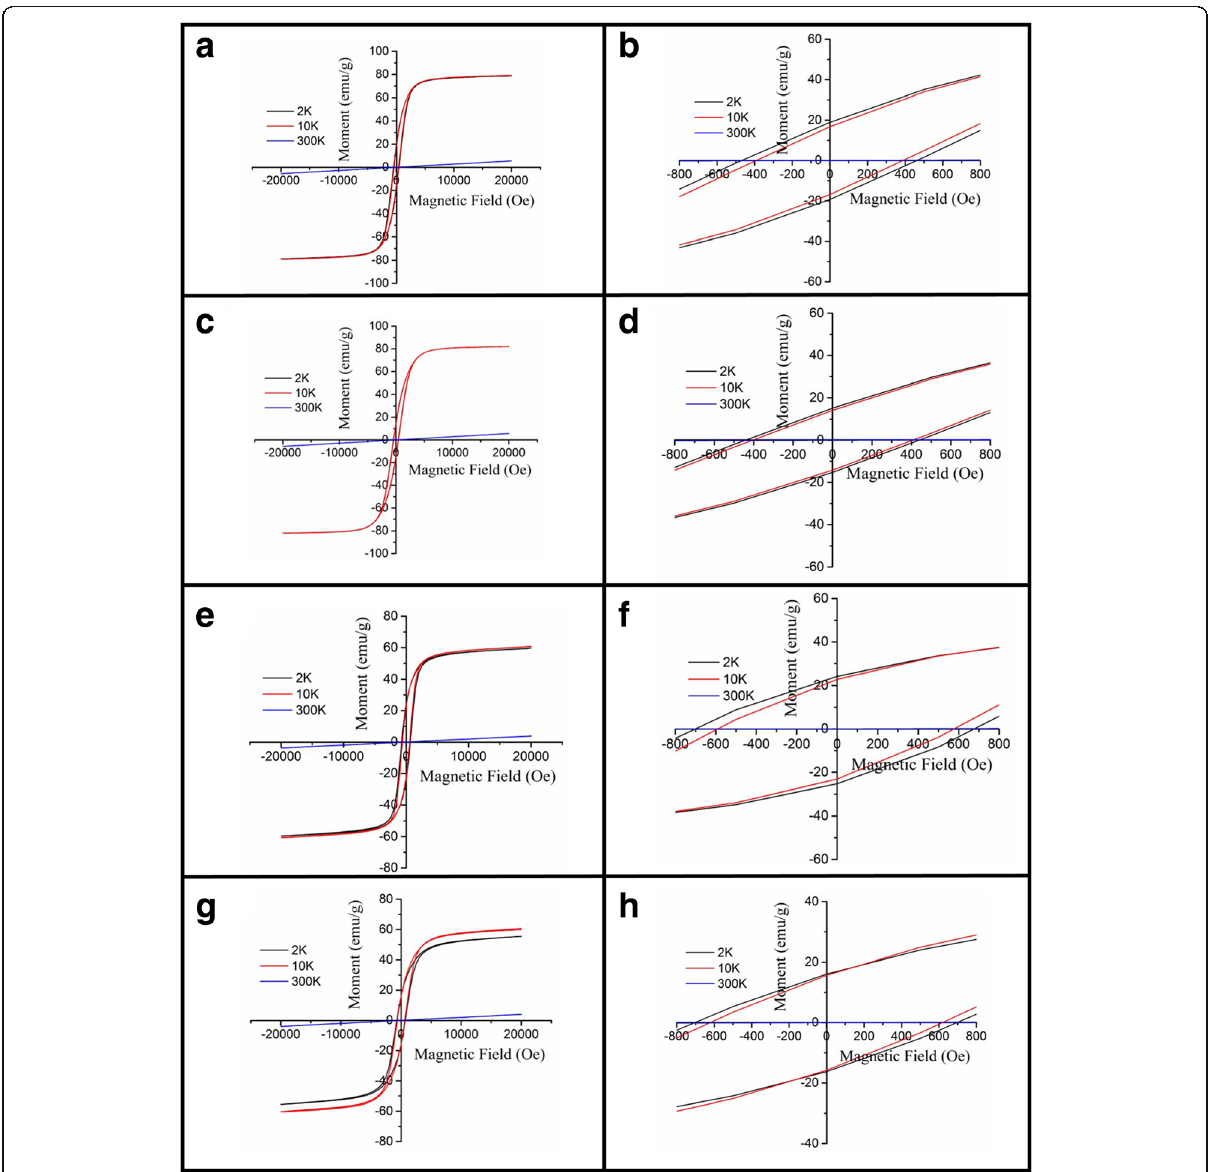
Fig. 12 M – H hysteresis loops of the (La 1 − x Pr x ) 0.67 Ca 0.33 MnO 3 nanoparticles post-annealed at 800 °C with different Pr-doping concentrations. a x =0.1, c x =0.2, e x =0.3, and g x =0.4. b , d , f , and h are the corresponding local enlarged M – H hysteresis loops in ( a , c , e , and g ), respectively